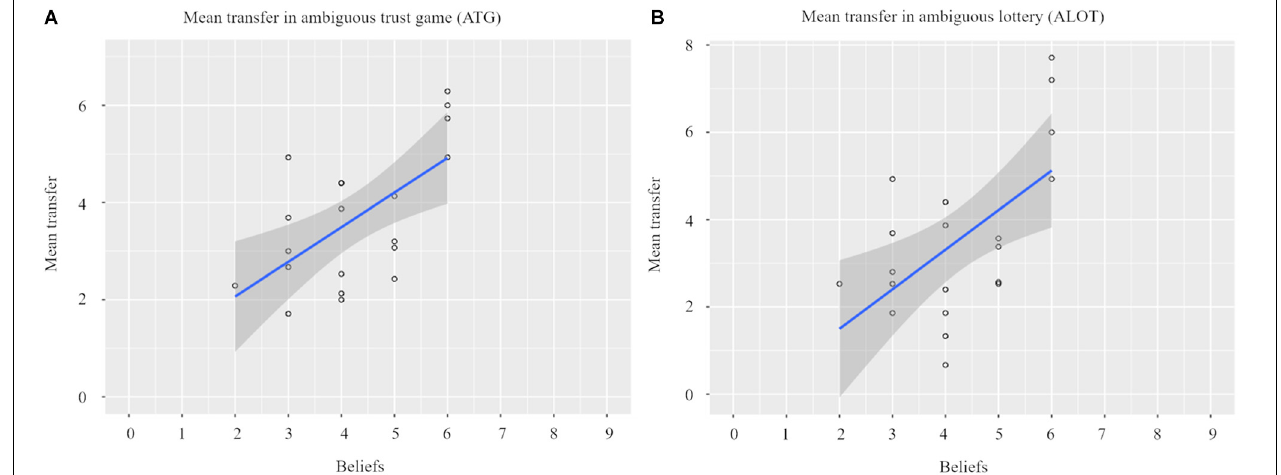
FIGURE 3 | Elicited beliefs regarding receivers’ reciprocity influenced chosen transfer in the ambiguous trust game Panel (A) . Based on individual beliefs, participants received a matching amount of winning colors in the ambiguous lottery. Participants used this information, given during instructions prior to the experiment in the MRI scanner, as transfer positively increased as a function of the amount of winning colors Panel (B) .